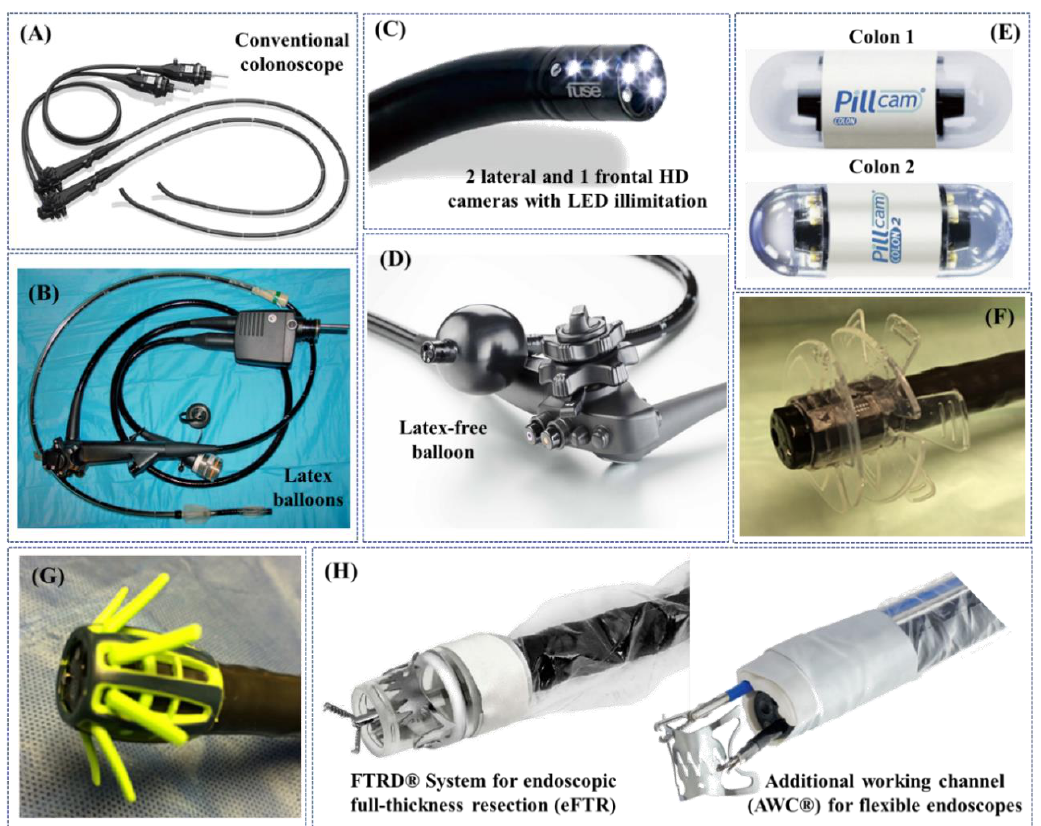
Figure 2. Examples of non-robotic colonoscopes and adjuncts used in the clinical practice: ( A ) standard colonoscope; ( B ) double-balloon colonoscope [47]; ( C ) Full Spectrum Endoscopy (FUSE, EndoChoice Inc., Alpharetta, GA, USA) [73]; ( D ) G-Eye endoscope (NaviAid G-EYE, SMART Medical Systems Ltd., Ra ’ anana, Israel) (Courtesy of PENTAX Europe GmbH); ( E ) PillCam TM Colon 1 and Colon 2 [74]; ( F ) EndoRings TM (EndoAid Ltd., Caesarea, Israel) [73]; ( G ) Endocuff VISION TM (Olympus Corp., Tokyo, Japan) [73]; ( H ) adjunct tools for colonoscopes designed and commercialized by OVESCO Endoscopy AG (Tübingen, Germany) (Courtesy of OVESCO Endoscopy AG).